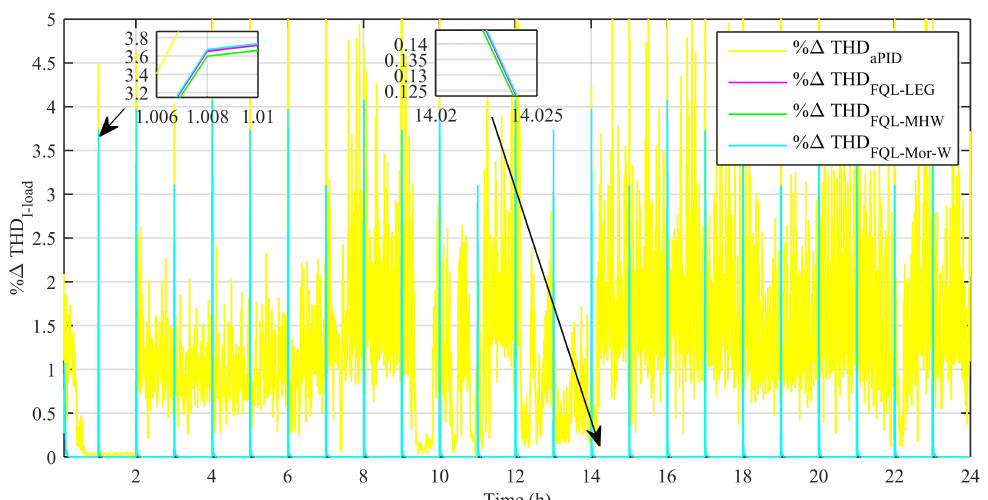
Figure 16. V rms load evolution.